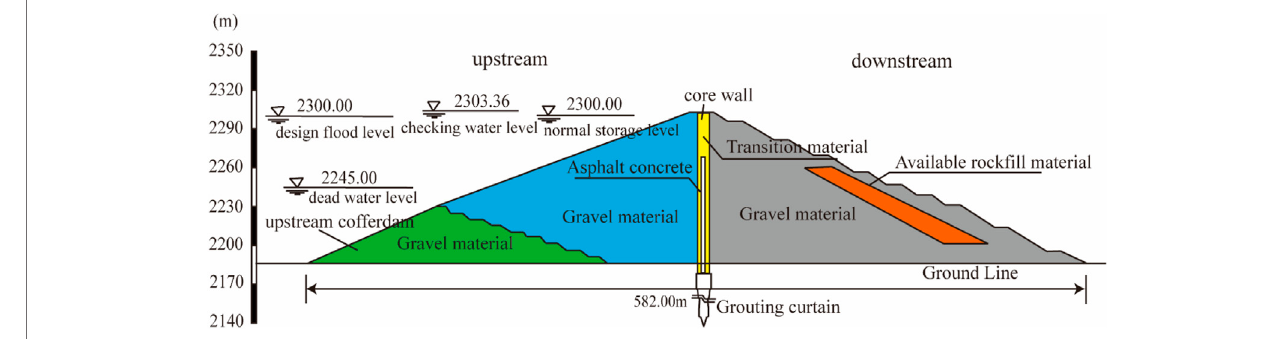
FIGURE 8 | Standard cross section of Dashimen asphalt concrete core dam.